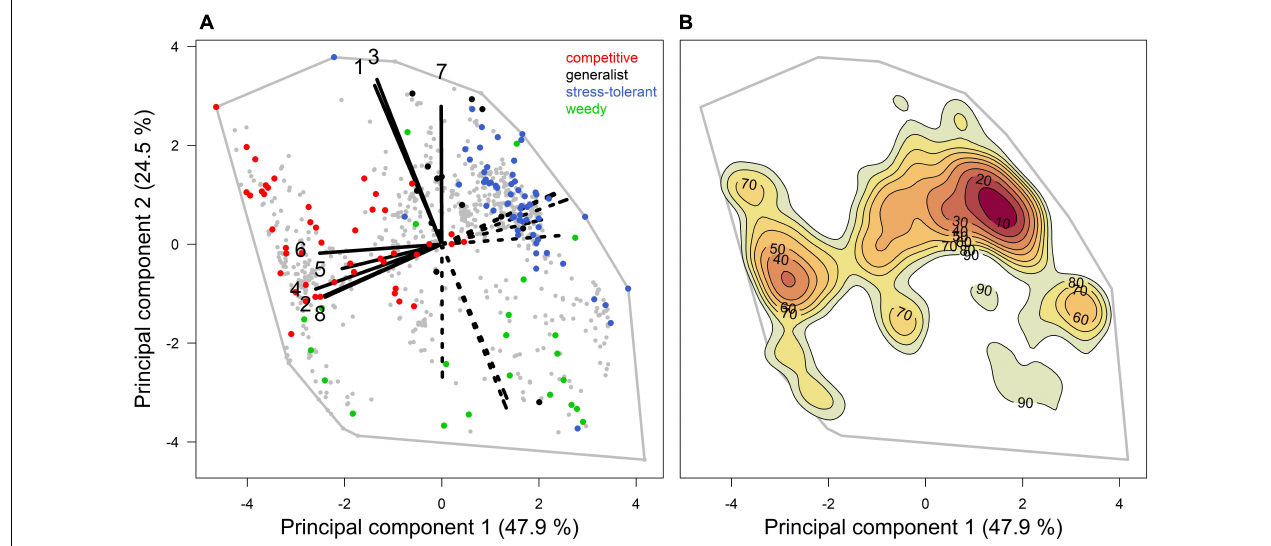
FIGURE 2 | Coral functional space from which we sampled coral species. Biplot (A) of the principal component analysis (PCA) shows the species distribution ( n = 798; gray dots in the left panel) and the loadings of the first and second principal components (black segments) which represent the following traits: (1) bleaching susceptibility, (2) colony complexity, (3) colony maximum diameter, (4) dislodgement susceptibility, (5) colony fecundity, (6) growth rate, (7) mode of larval development, and (8) overtop capacity (cf. Supplementary Table 2 for the values of the loadings). The red, black, blue, and green dots represent the competitive, generalist, stress-tolerant, and weedy species, respectively (cf. Darling et al. (2012) classification). Biplot (B) describes the species density with color gradient and contour lines (based on kernel density estimation). Note that we sampled species in the space defined by the first four principal components (cf. Construction of the Communities and Supplementary Figure 4